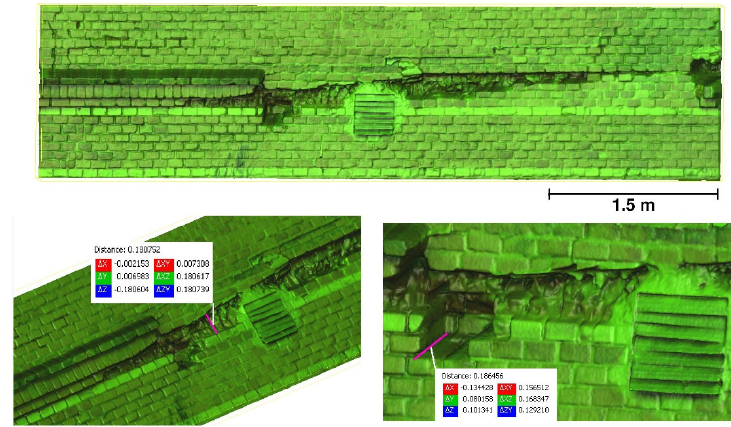
Figure 11. Three-dimensional model of the most deteriorated part of the Figure 11. Three ‐ dimensional model of the most deteriorated part of the wall.